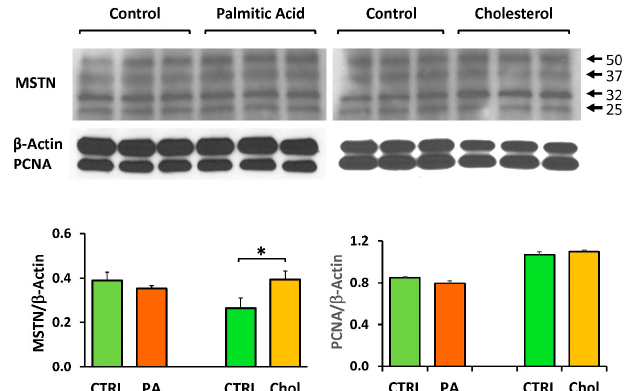
Figure 6. ZF4-SC were only mildly induced by cholesterol, or not by Na palmitate, to overexpress myostatin, a lipofibrotic e ff ector, and not a ff ected for the expression of PCNA, a proliferation mediator. ZF4-SC were incubated in triplicate, as in Figure 5, with or without cholesterol or Na palmitate addition, but until day 4 close to confluence. Then cells were collected for Western blot analysis, probing sequentially with antibodies against myostatin, β -actin as a housekeeping protein, and PCNA, followed by the respective secondary antibodies and luminol. The bands for myostatin (MSTN) (50, 32, and 25 kDa) are shown on top. The ones for β -actin (42 kDa) and PCNA (36 kDa) from the re-probing and re-exposures are below them. At the bottom: densitometry graphs for MSTN and PCNA, corrected by β - actin.; * p < 0.05 (CHOL vs. CTRL). The potential direct damage in vitro of ZF4-SC stemness by lipid factors was studied as an initial approach by determining by Western blot their effects on the expression of the key stem cell factor octamer-binding transcription factor 4 (Oct 4). Its 45 kDa nuclear isoform is considered as the true stemness isoform Oct4A, rather than its cytoplasmic 33 kDa Oct4B isoform [11–13]. Figure 7 shows that, contrary to expectations, both cholesterol and palmitate did not downregulate the 45 kDa band, but upregulated the 33 kDa band, thus altering the 45/33 kDa nuclear/cytoplasmic ratio.